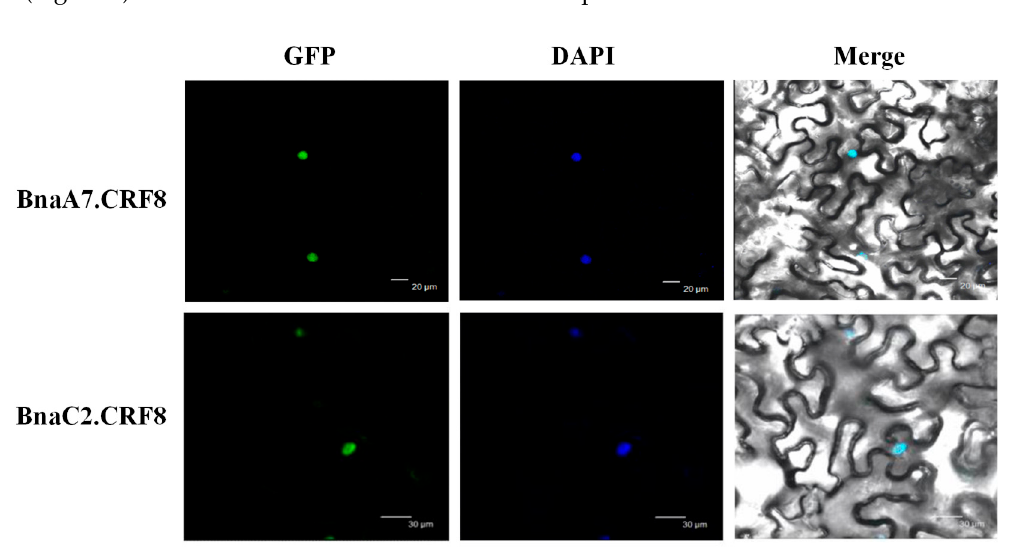
Figure 5. Subcellular localization of BnaA7.CRF8 and BnaC2.CRF8. Tobacco leaves were infiltrated with Agrobacterium harboring 35S::BnaA7.CRF8-GFP and 35S::BnaAC2.CRF8-GFP , respectively. DAPI (4 ′ ,6-diamidino-2-phenylindole) staining was used to indicate the positions of nuclei. GFP, green fluorescent protein.